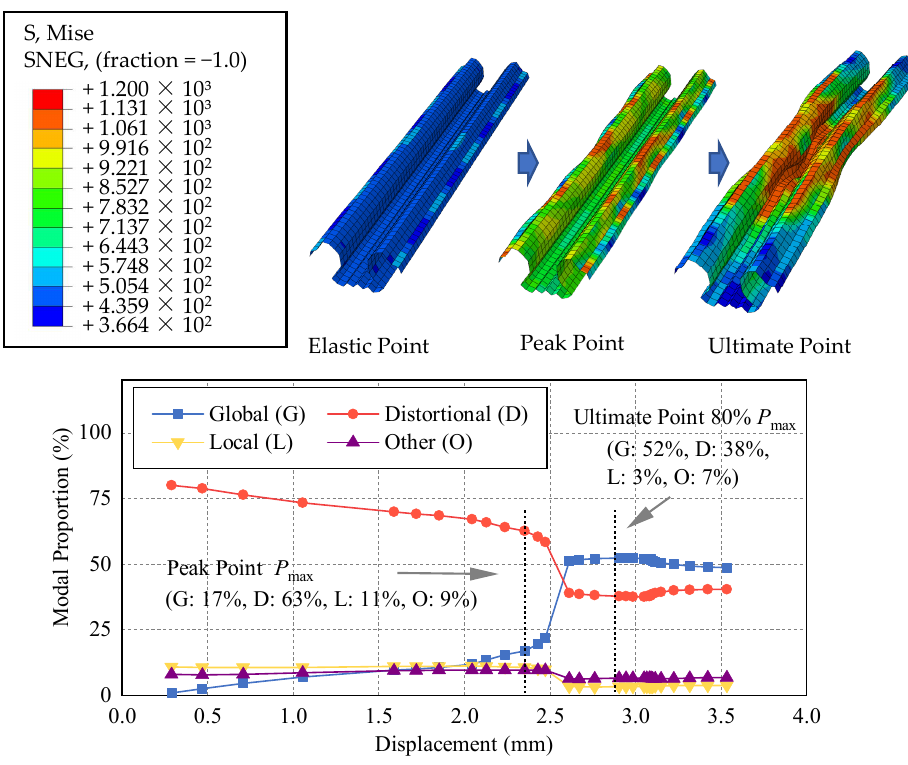
Figure 21. Full range modal participation of